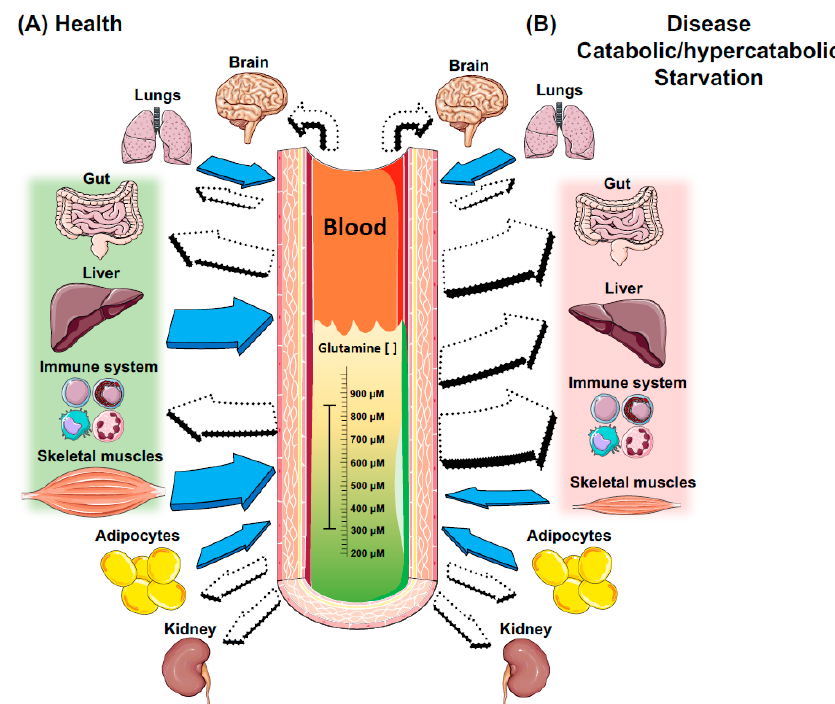
Figure 2. Intertissue glutamine production and utilisation in health and catabolic/hypercatabolic situations. Filled arrows indicate tissues that exhibit GS activity and thus produce glutamine; white arrows indicate tissues that exhibit GLS activity, and thus consume glutamine. In health and/or fed states, glutamine stores are in equilibrium in plasma/bloodstream and tissues, and are maintained constantly mainly by the liver and skeletal muscles, two major stores of glutamine in the body. On the other hand, cells of the immune system are extremely dependent on glucose and glutamine in situation ( A ), and even more in situation ( B ). Although the gut is a major site of glutamine consumption, in situation ( B ), there is a dramatic increase in glutamine consumption from both the luminal and basolateral membrane, when compared to situation ( A ). In addition, the liver switches the role of a major producer to a major glutamine consumer to maintain gluconeogenesis, and the whole body relies on the skeletal muscle’s ability/stores to maintain glutamine levels. However, this process is usually accompanied by a dramatic increase in muscle proteolysis, atrophy, and cachexia. The lungs and adipose tissue exhibit both GS and GLS enzymes, and hence can produce and consume glutamine in situations ( A ) and ( B ). The brain and the kidneys do not exhibit GS, only GLS, and hence are mainly dependent on plasma glutamine availability in situations ( A ) and ( B ).